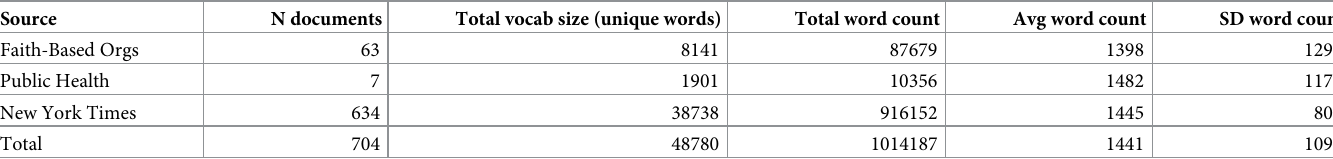
Table 1. Descriptive statistics for three